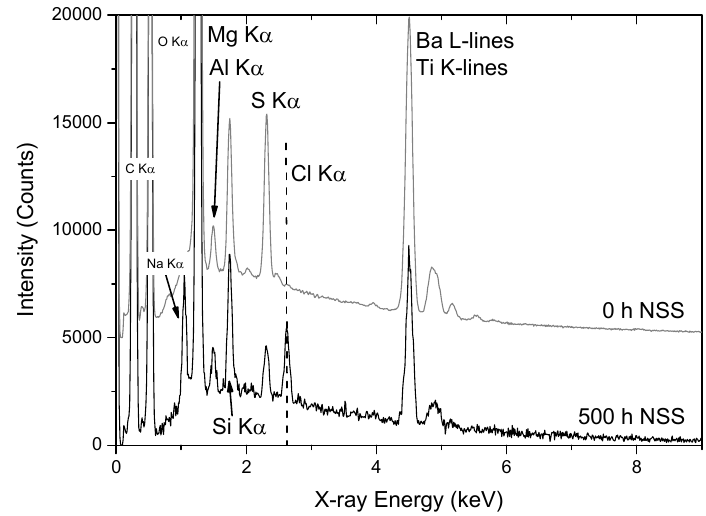
Figure 11. Sample spectra from X-sections of the polyurethane coatings without exposure to (from Figure 5) and 500 h exposure to NSS (Figure 10), respectively. The points from which the spectra have been taken are indicated in each figure by the dashed circle.